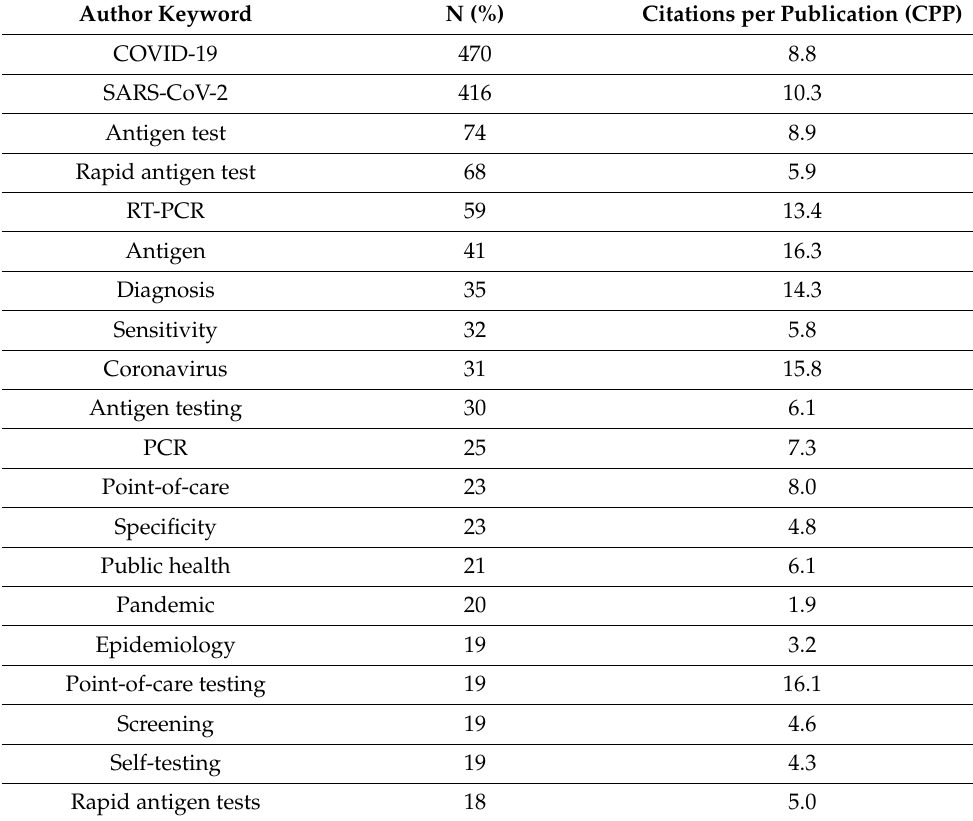
Table 2. Top 20 author keywords in the literature concerning the COVID-19 rapid antigen test (N—number of